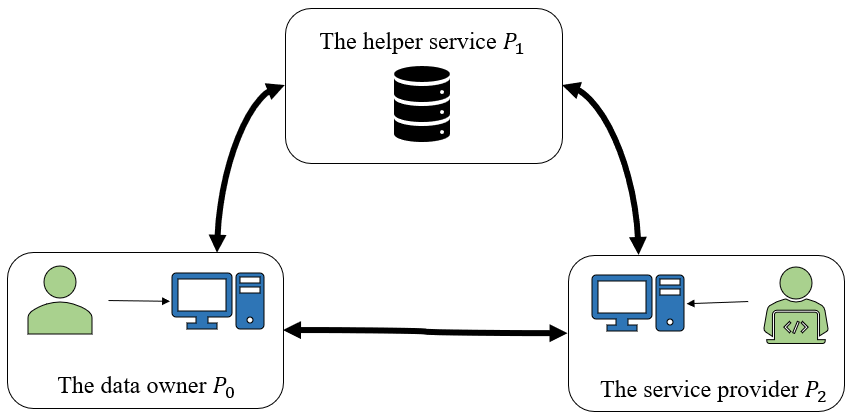
Figure 1. The prediction model for three-party secure